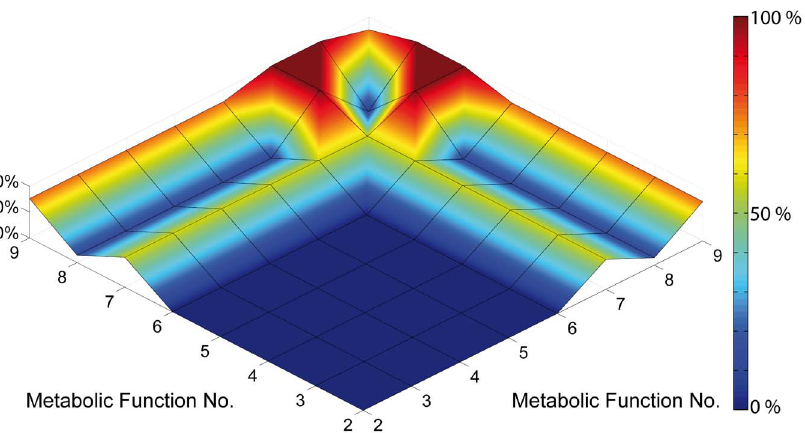
Figure 6. Contribution of metabolite interconversion functions to the best numerical solution of the simplified metabolic network model. Numbers of metabolite interconversion functions are indicated on x- and y-axis. The colour bar indicates the relative decrease of the cost function value, i.e. improvement of solution, when a function or a combination of functions was varied during the optimization process. All cost function values were normalised to the best of all optimization runs (100%). Functions were optimized for the simulation of the metabolic homeostasis of Col-0 under extended darkness.